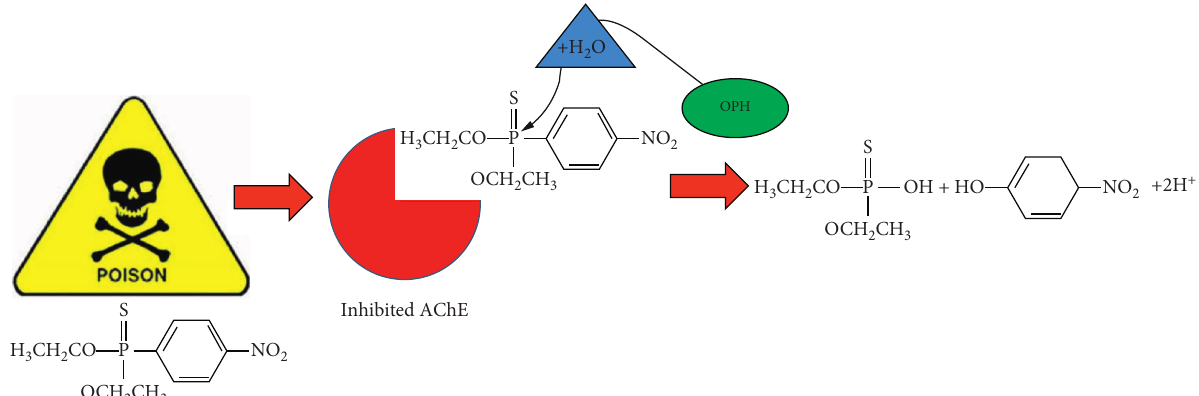
Figure 8: Schematic of OP insecticide hydrolysis by OP hydrolases. The products of hydrolysis do not inhibit